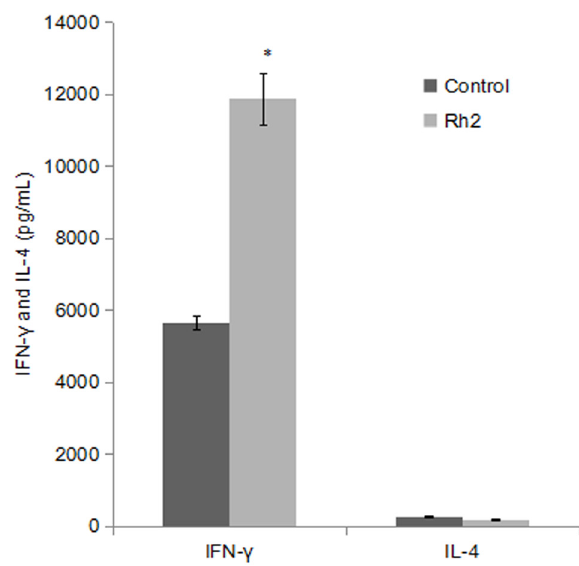
on IFN-γ and IL-4 in the culture 2